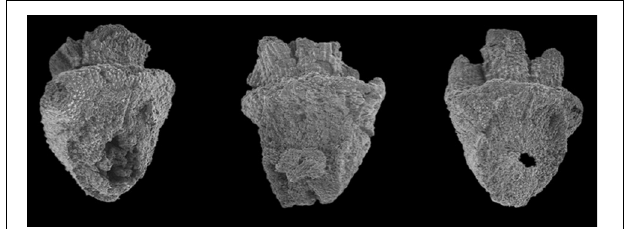
FIGURE 4 | Rice spikelet bases from Masudpur I showing domesticated, wild, and immature types. Authors own work, originally published